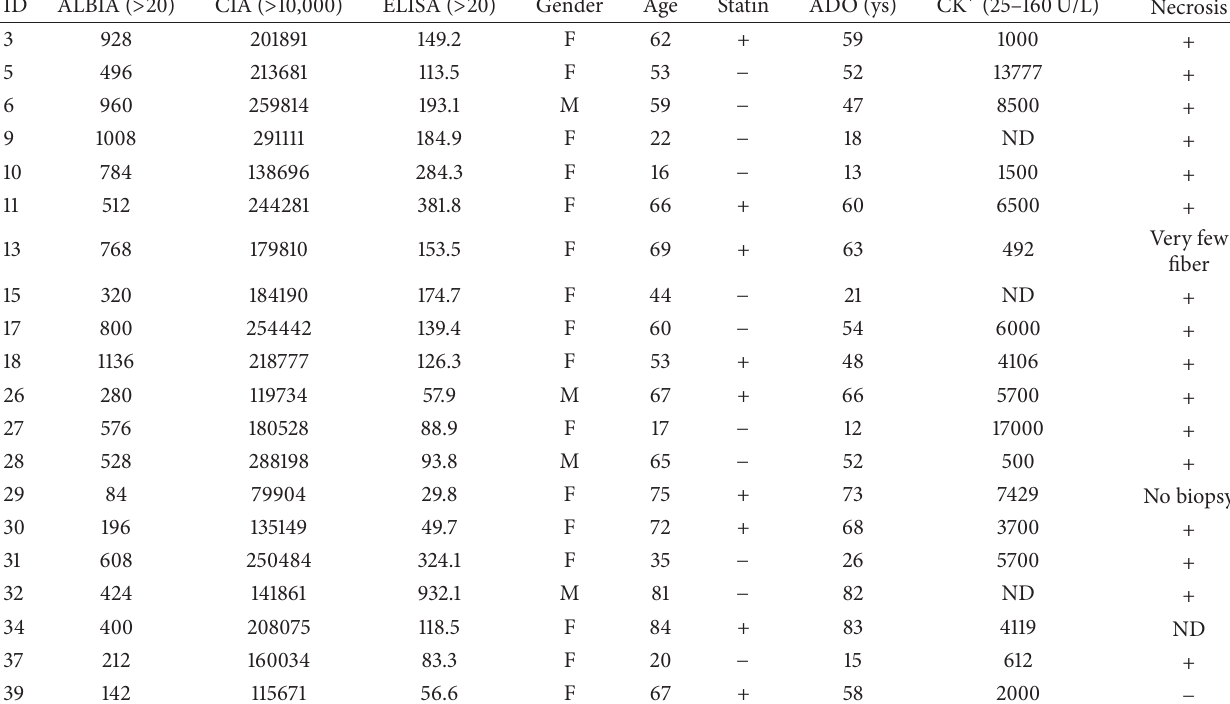
Table 1: Clinical and serological data of anti-HMGCR positive